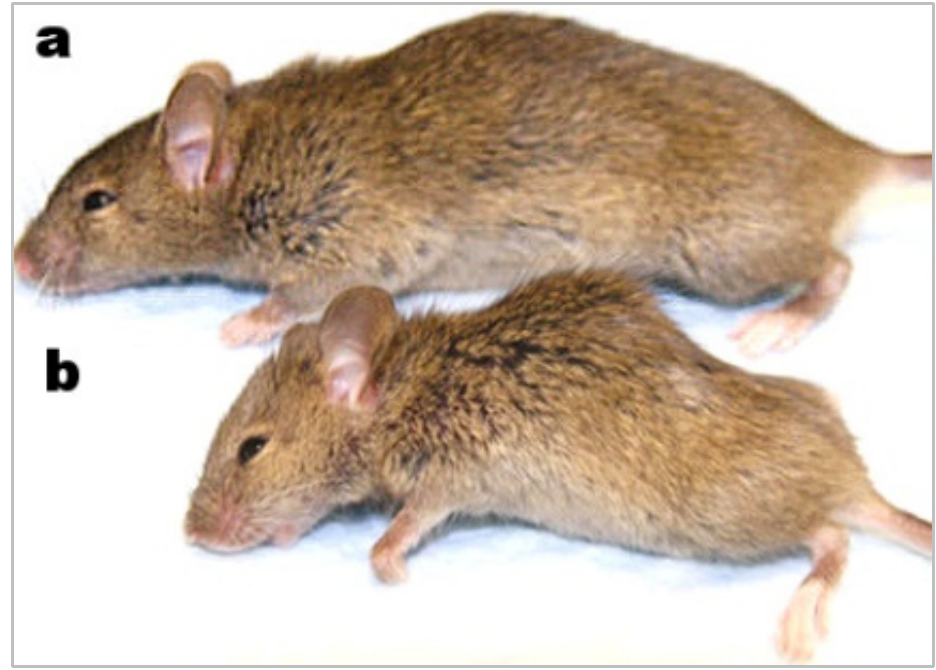
Figure 1. Wild-type mouse ( a ) and smaller-sized klotho mutant mouse with kyphosis ( b ).